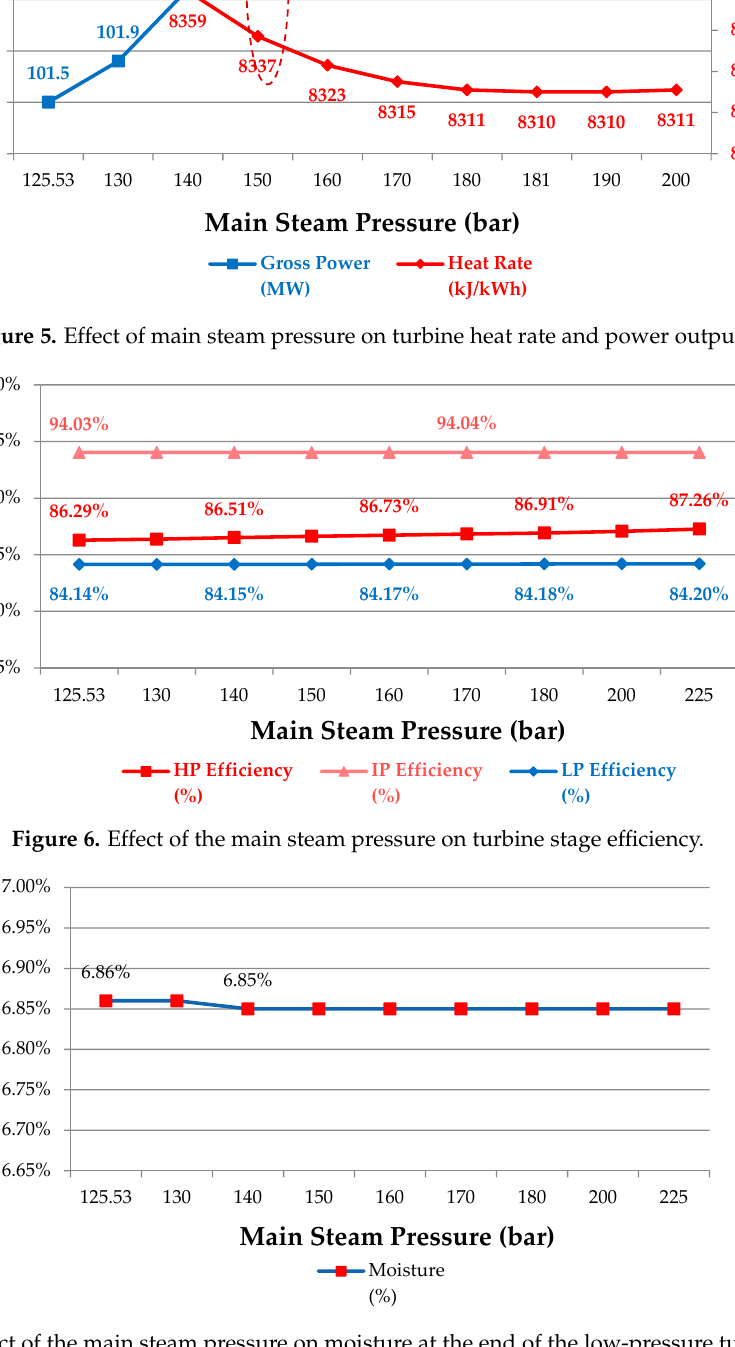
Figure 7. Effect of the main steam pressure on moisture at the end of the low-pressure turbine cycle.